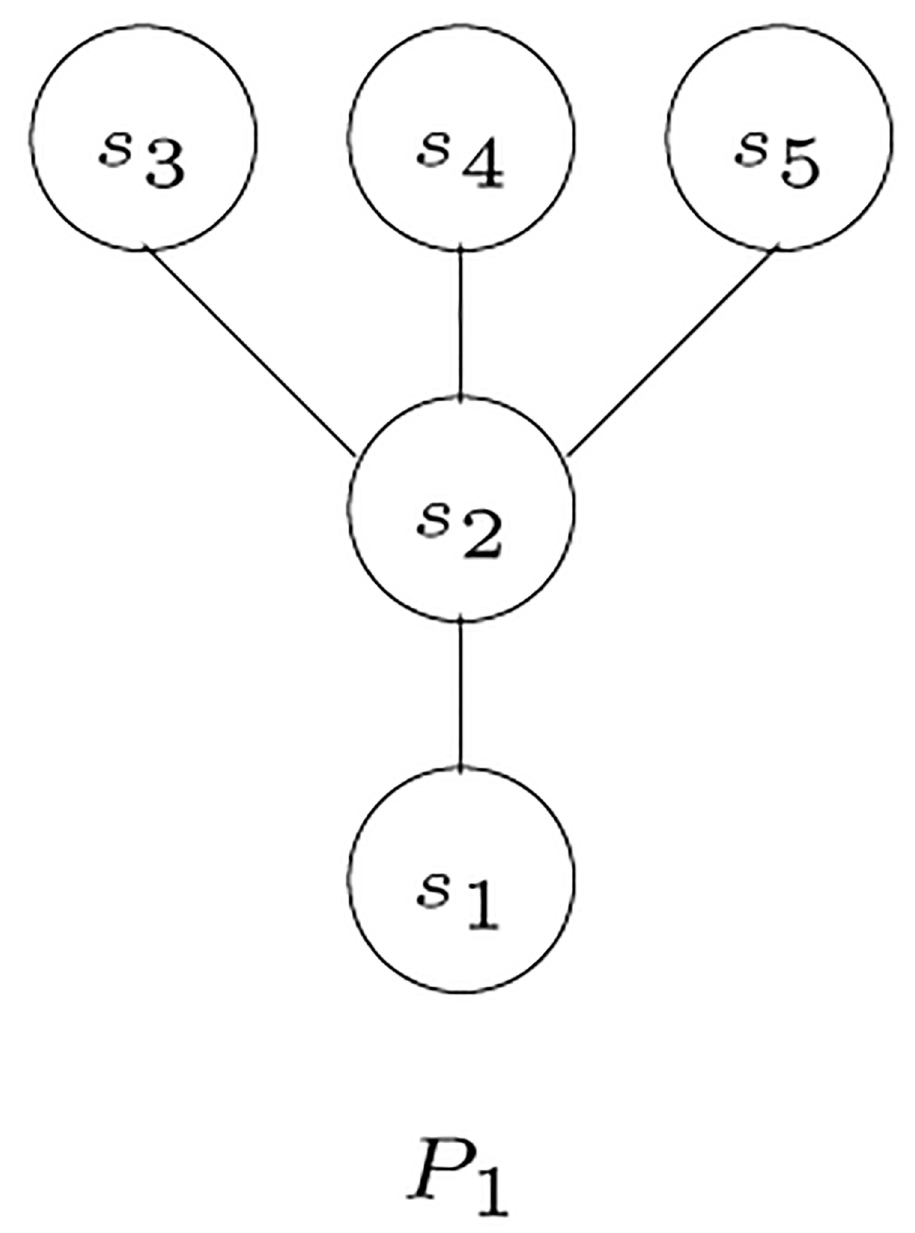
Fig 7. An example of a poset compatible with the tree in Fig 6